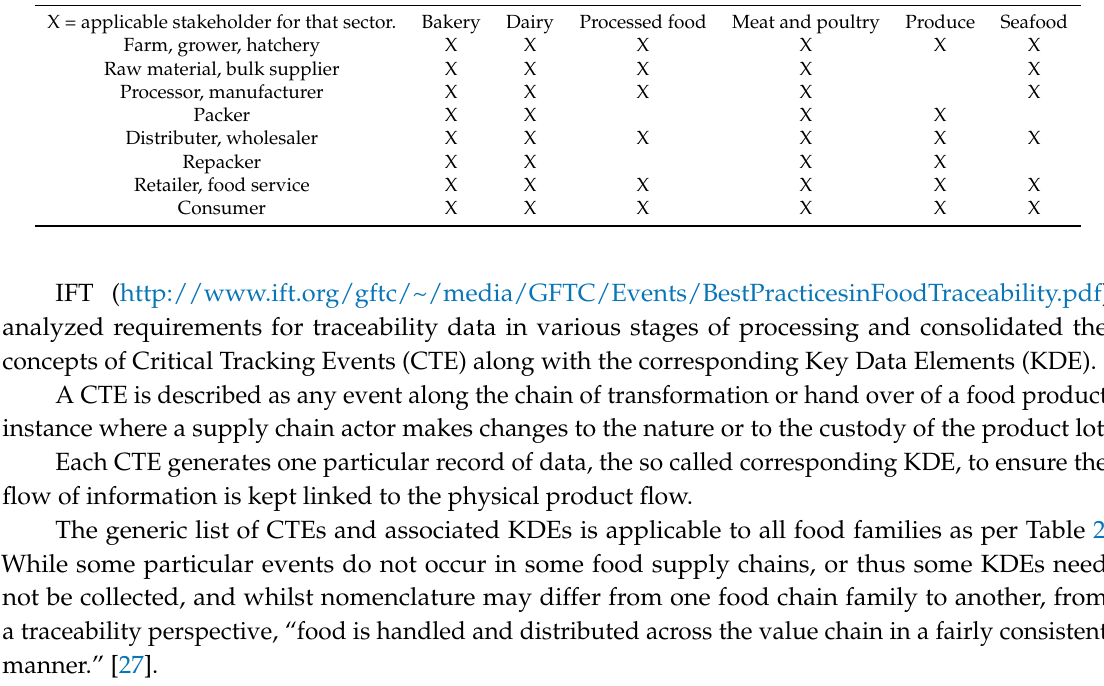
Table 1. List of typical actors and stakeholders for different food chains [27]. Stakeholder Recipe Based Foods Non Recipe Based Foods X = applicable stakeholder for that sector.